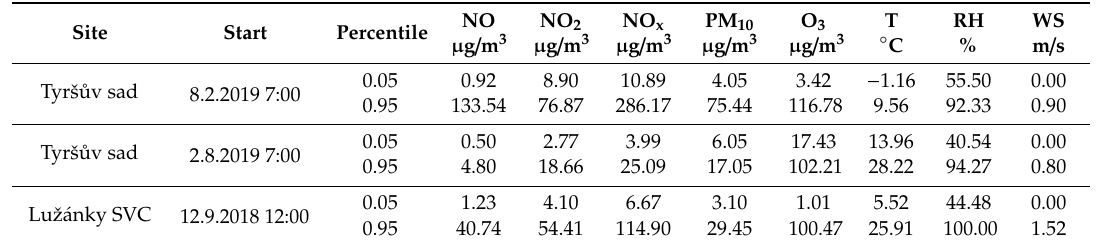
Table 3. The measurement results: the 0.05 and 0.95 percentiles of the measured parameters.